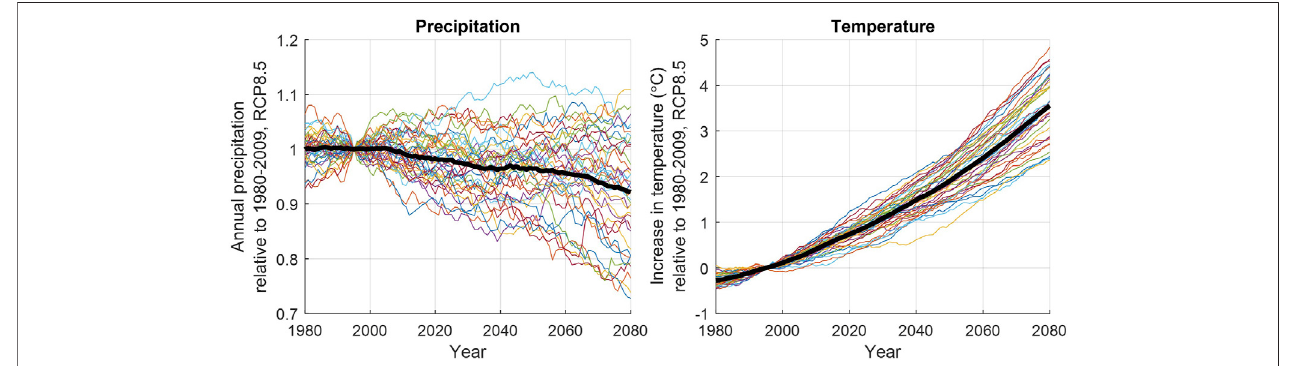
FIGURE 3 | Climate model projections for annual precipitation and temperature for the Goulburn River basin for RCP8.5. Each colored line is a CMIP5 model projection. The bold black line is the multi-model-mean